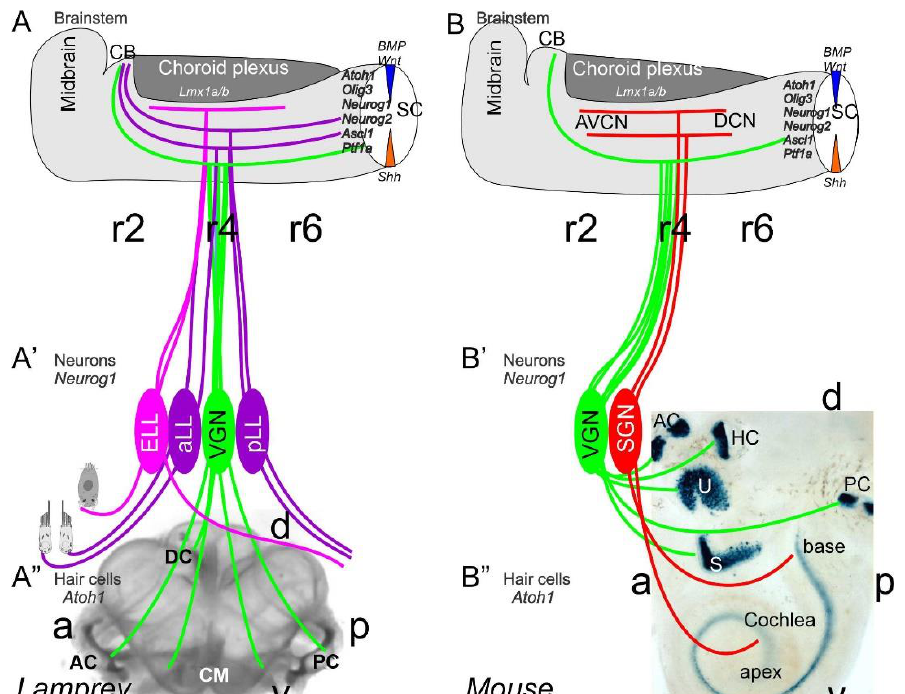
Figure 1. Inner ear, lateral line and electroreception revealed. Neurons ( Neurog1 ; A’ ) form vestibular ganglia (VGN) to reach out 4 hair cell organs in lampreys ( A” ). A separate lateral line (LL) and electroreceptor neurons (ELL) that innervate hair cells project more dorsal in lampreys. Central projection depends on Atoh1 to receive LL and ELL fibers, whereas several bHLH genes ( Neurog1/2, Olig3, Ascla1, Ptf1a ) receive all VGN ( A ). In the absence of ELL and LL development in amniotes, mammals develop separate spiral ganglion neurons (SGN; B’ ) that extend from the cochlea ( B” ) and end in a topological central projection that depends on Atoh1 ( B ). The formation of VGNs ( Neurog1 ; B’ ) reach the 5 hair cells ( B” ) to extend the distribution of bHLH genes. Note that certain areas are lost or gained which enter central projections near r4. Images are shown by miR-183 ISH ( A” ) and Atoh1 -LacZ ( B” ). AC, anterior crista; AVCN, anteroventral cochlear neurons; CB, cerebellum; aLL, pLL, anterior/posterior lateral line neurons; CM, common macula; DC, dorsal crista; DCN, dorsal cochlear neurons; HC, horizontal crista; PC, posterior crista; r2/4/6, rhombomeres; S, saccule; SC, spinal cord; U, utricle. Modified after [11,30,31].